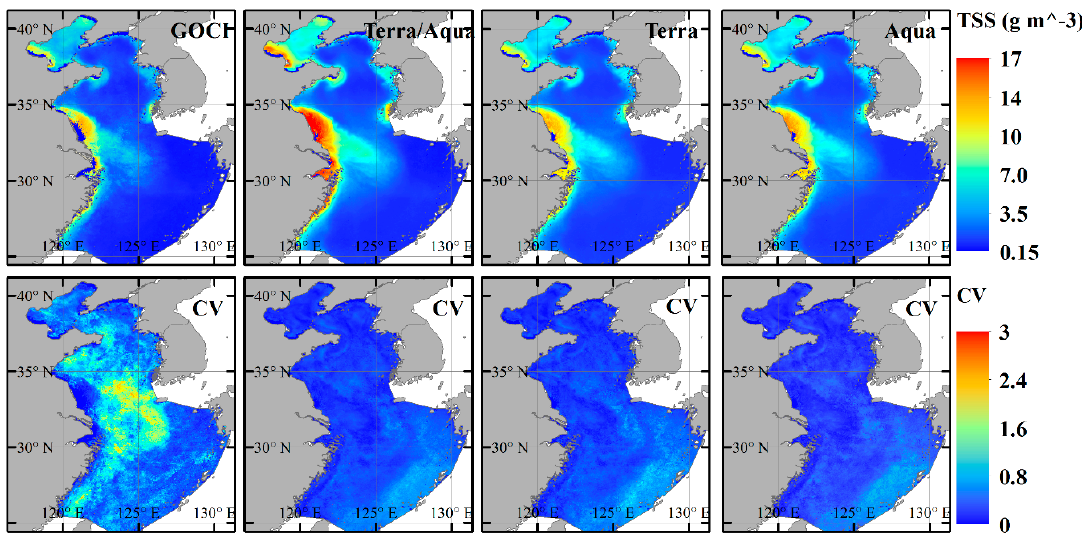
Figure 16. Annual mean TSS distributions and CV of China’s seas from different sampling frequency observations from 2013 to 2017.